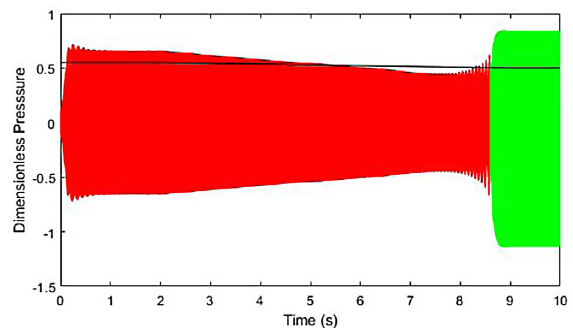
Figure 6. Signal (dimensionless acoustical pressure) obtained by simulation in time domain with an inharmonicity Inh = 0.04 and Z 1 = 1.5 Z 2 (like in Fig. 3c). The dimensionless mouth pressure is printed in black, and is decreasing linearly from c = 0.55 (constant before t = 2 s) to c = 0.50 (constant after t = 9